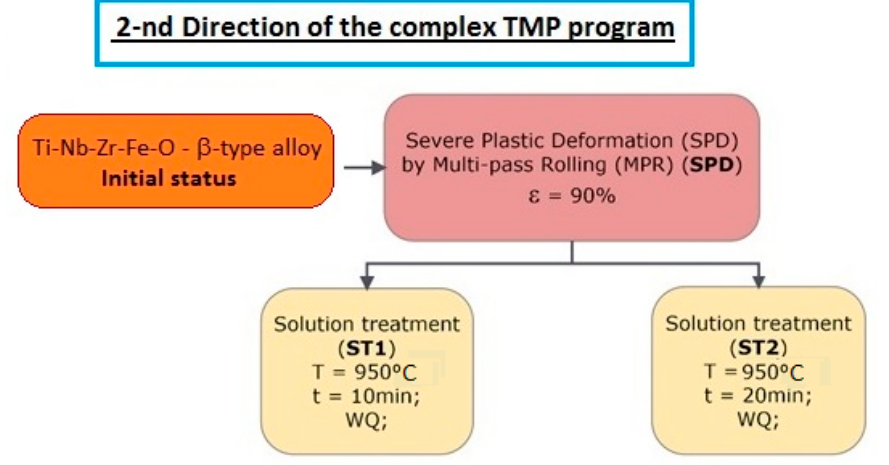
Figure 3. The 2nd Direction of the complex TMP Program applied to the studied β -type Ti-Nb-Zr-Fe-O alloy.